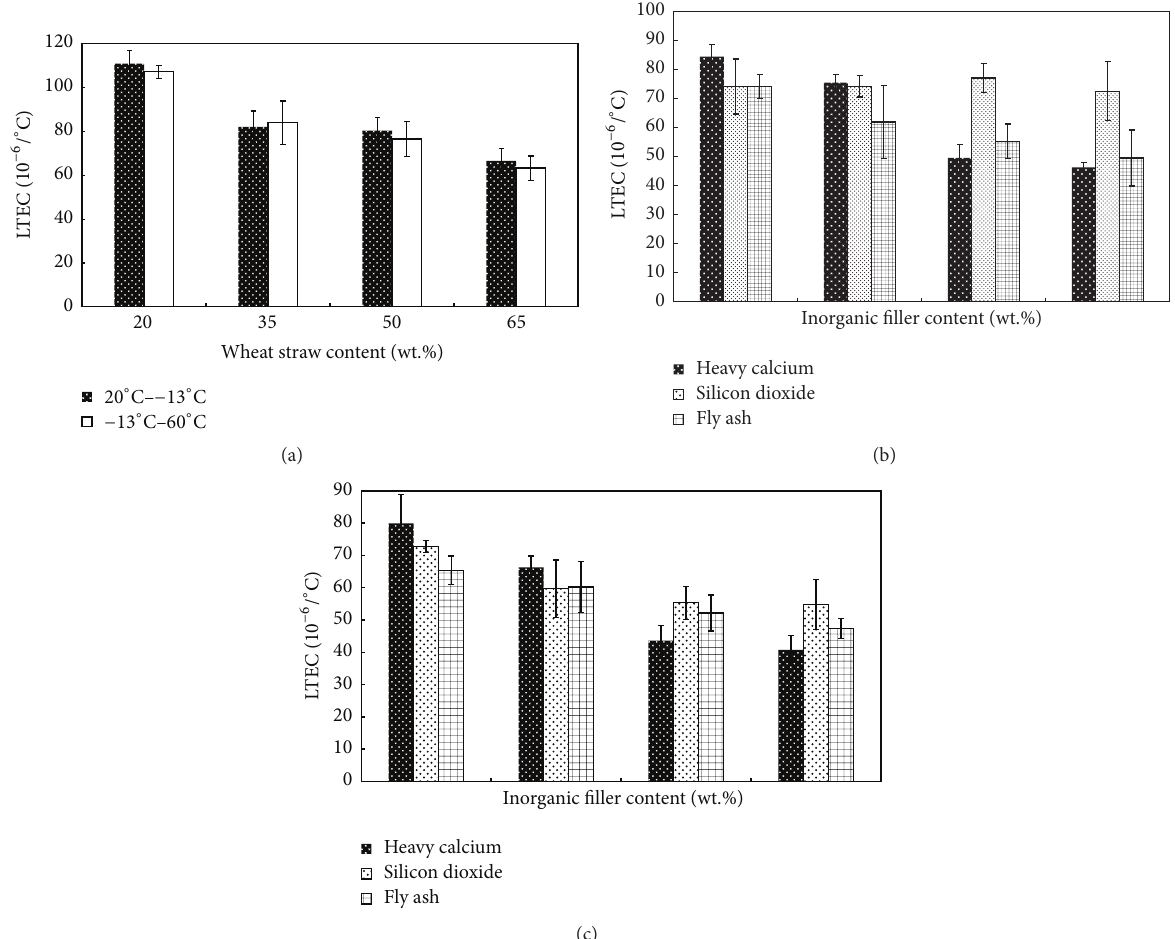
Figure 7: Thermal expansion properties of WS filled PP composites (a) and WS and inorganic filler reinforced PP composites (b) 20– − 13 ∘ C; (c) − 13–60 ∘